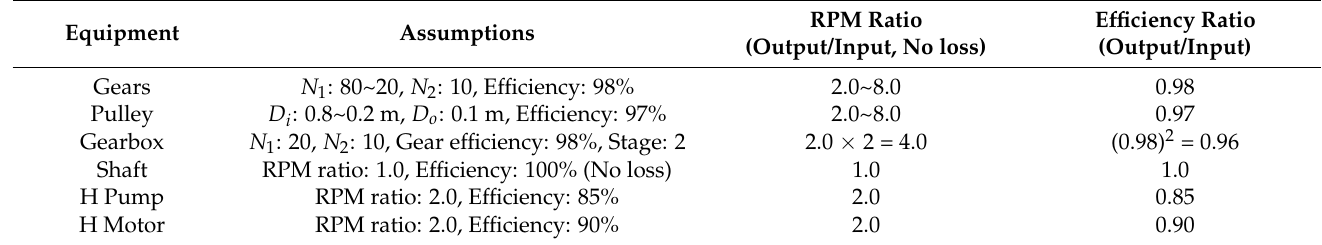
Table 4. Assumptions and RPM ratio and efficiency ratio of input/output for each equipment.